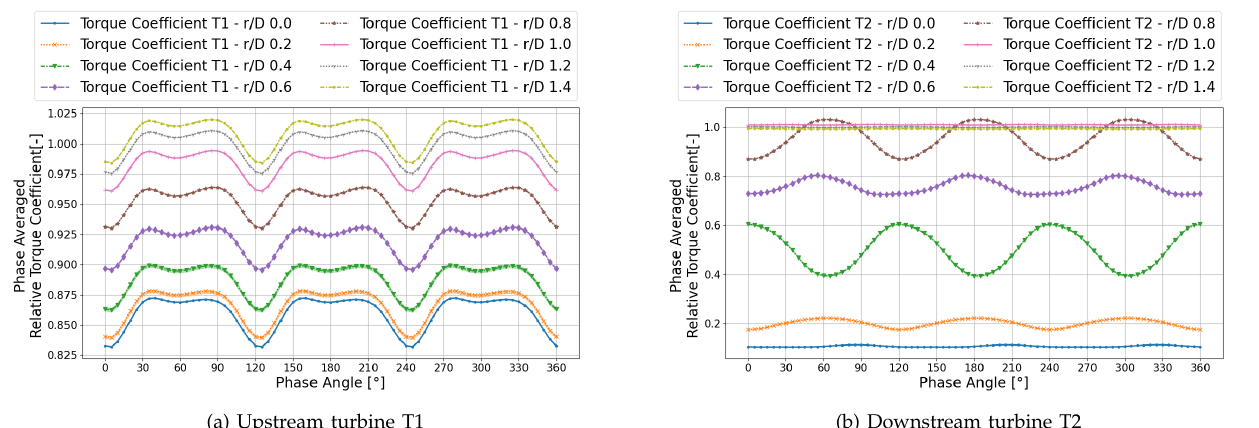
Fig. 10. Phase averaged torque coefficients for both turbines relative to mean of case r/D = 1 . 2 . A phase angle Φ ∈ [0 ◦ , 120 ◦ , 240 ◦ ] denotes one blade of the turbine being in top vertical position.